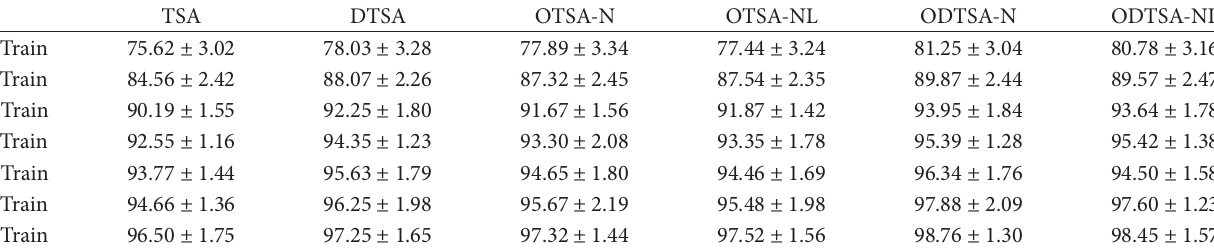
Table 2: Recognition accuracy ( % ) on ORL database (mean ± std).